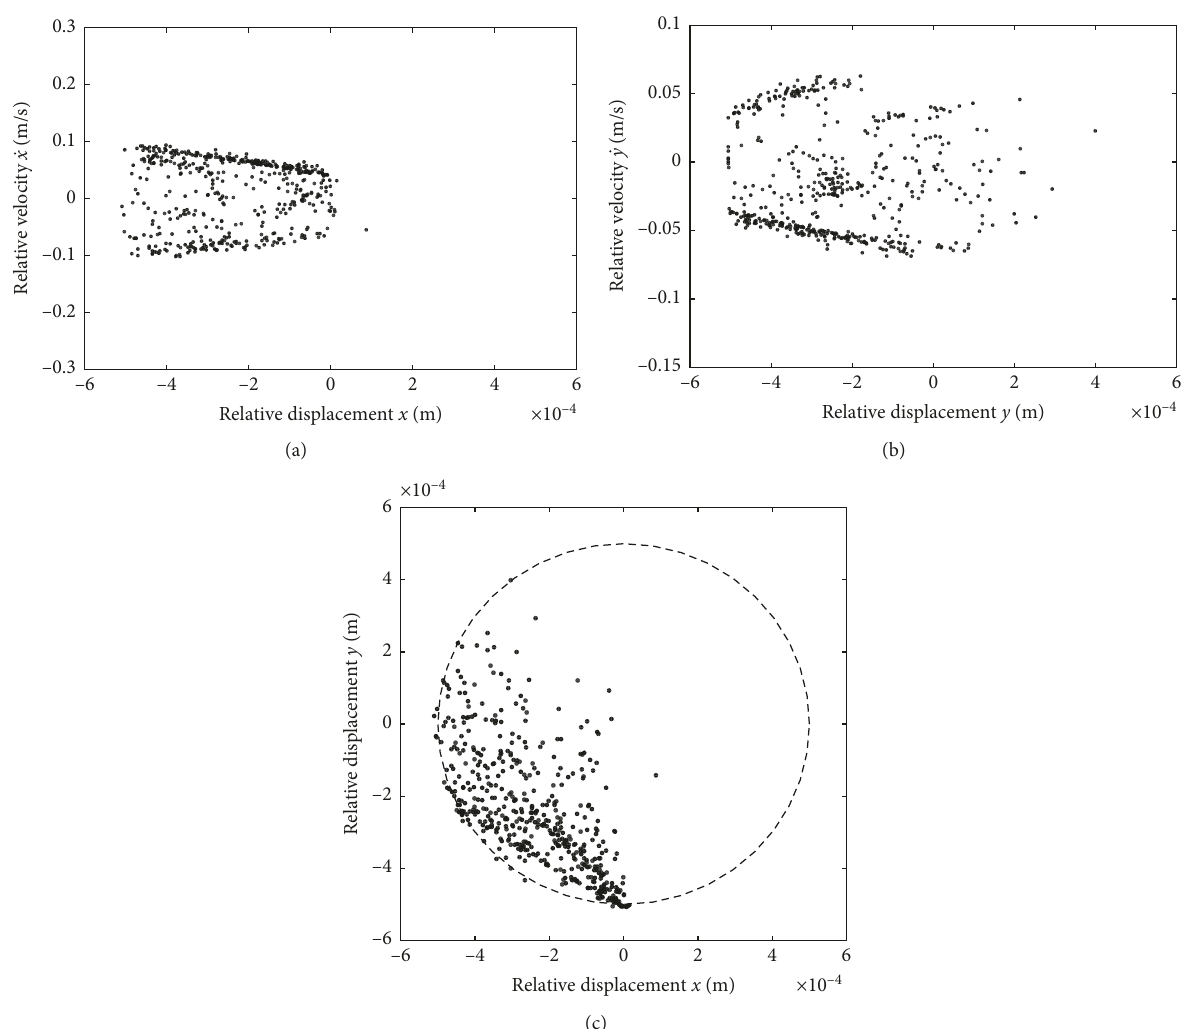
Figure 9: Poincar´e map of 2-DOF nine-bar mechanism: (a) relative displacement and relative velocity in x direction; (b) relative dis- placement and relative velocity in y direction; (c) relative displacement in x and y